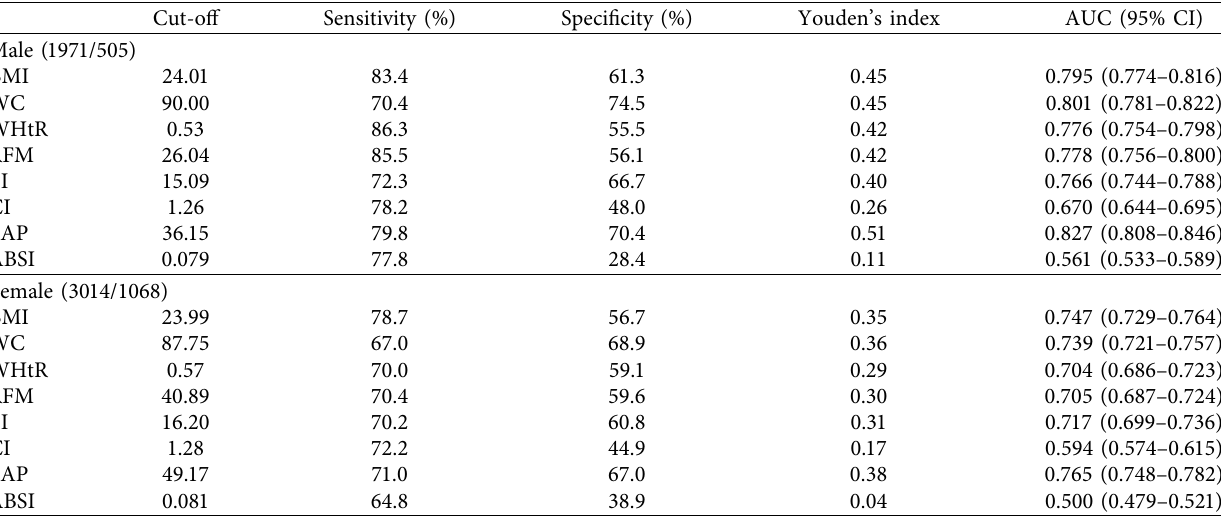
Table 6: The cut-off, sensitivities, specificities, Youden’s index, and area under the curve of different variable for the screening of NAFLD in men and women.